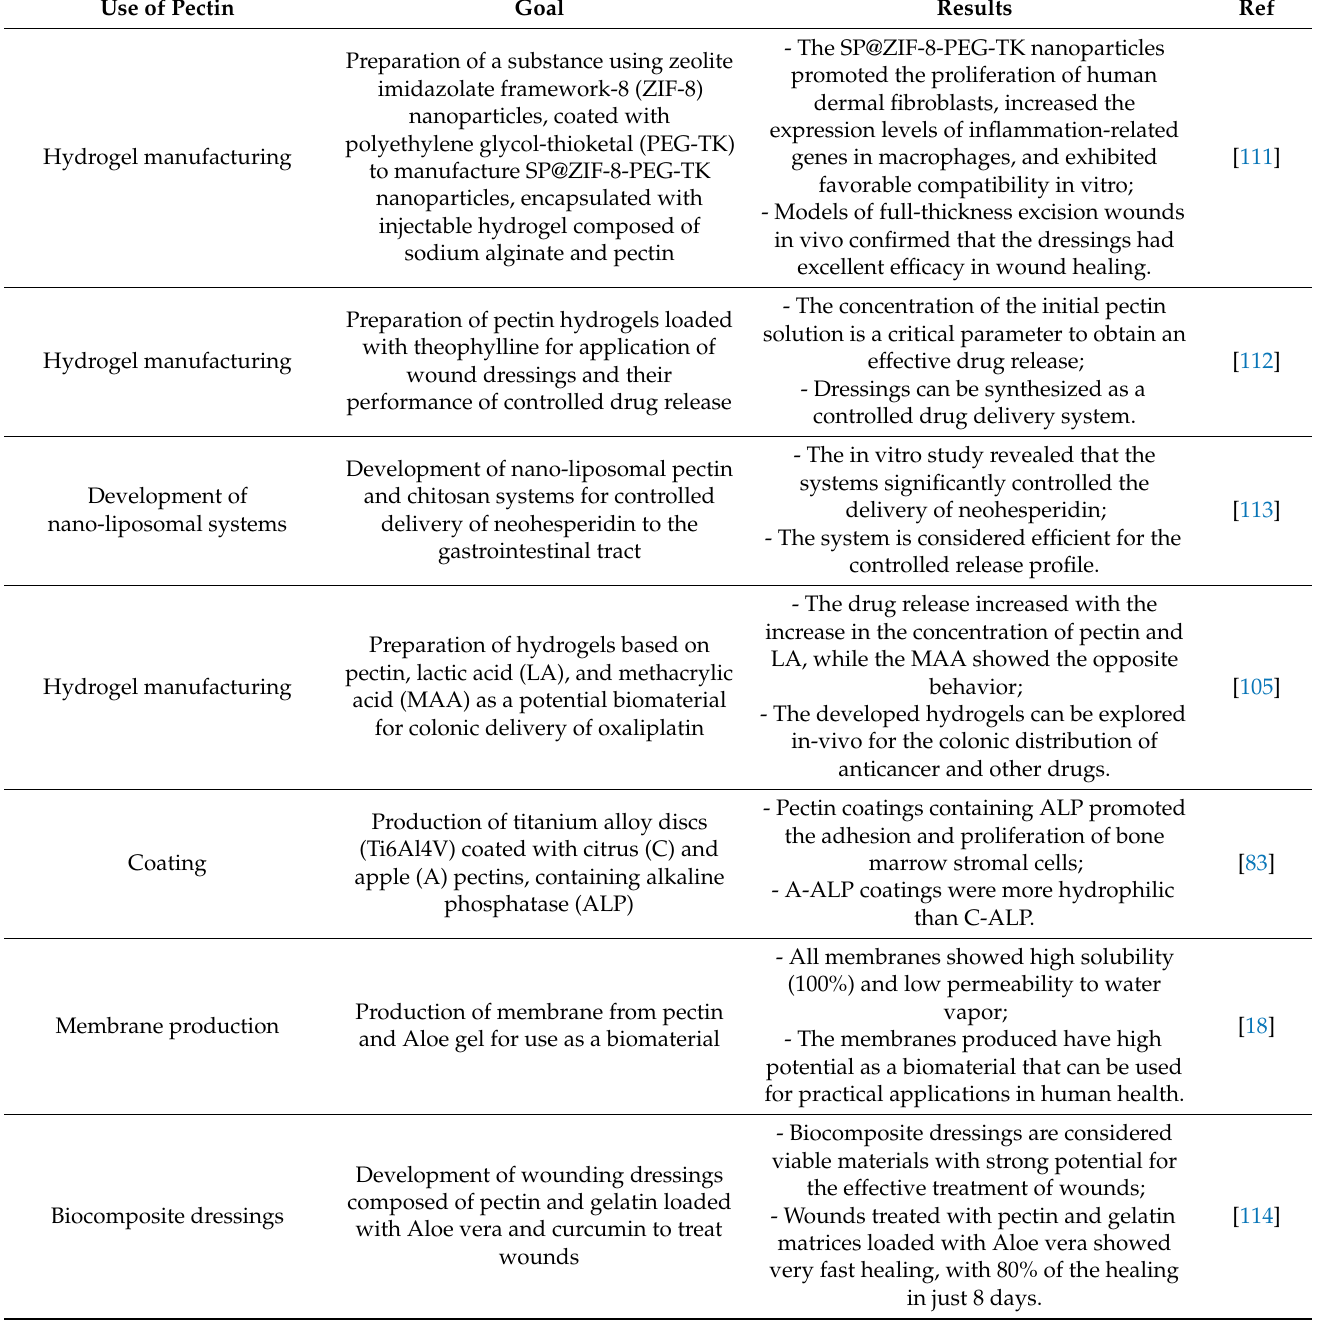
Table 4. Studies using pectin as a biomedical